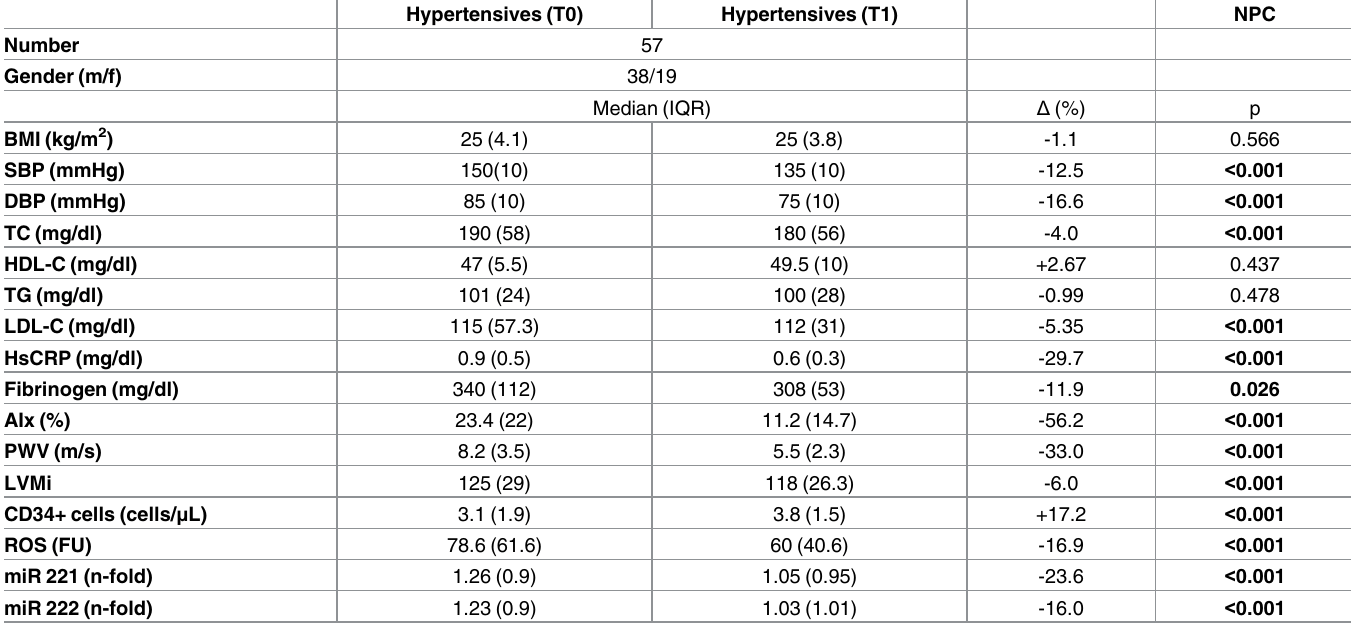
Table 2. Characteristics of hypertensive patients at baseline (T0) and after 6-months antihypertensive therapy